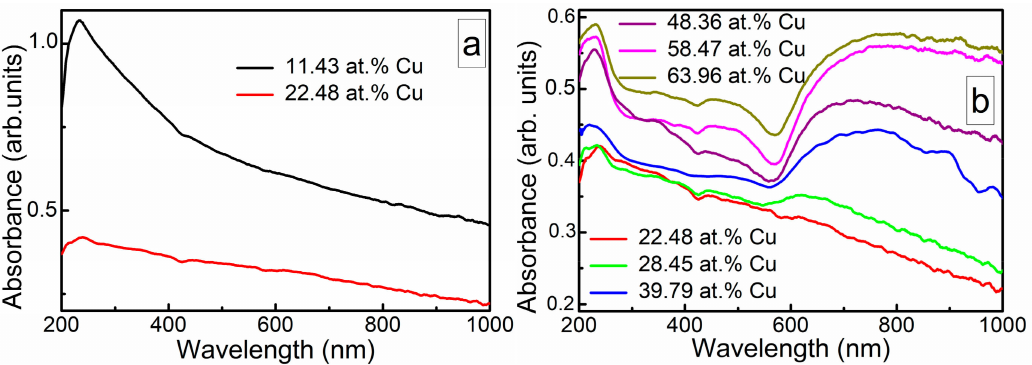
Figure 8. The representative optical absorbance spectra of DLC:Cu films: ≤ 22.48 at.% Cu, disappearance of diamond like carbon (DLC) related absorption peak at lower wavelengths ( a ); ≥ 22.48 at.% Cu, rise of the plasmonic peak ( b ). Absolute absorbance values are adjusted to make their analysis easier. The absorbance curves were lined up according to the Cu amount in the films in ( b